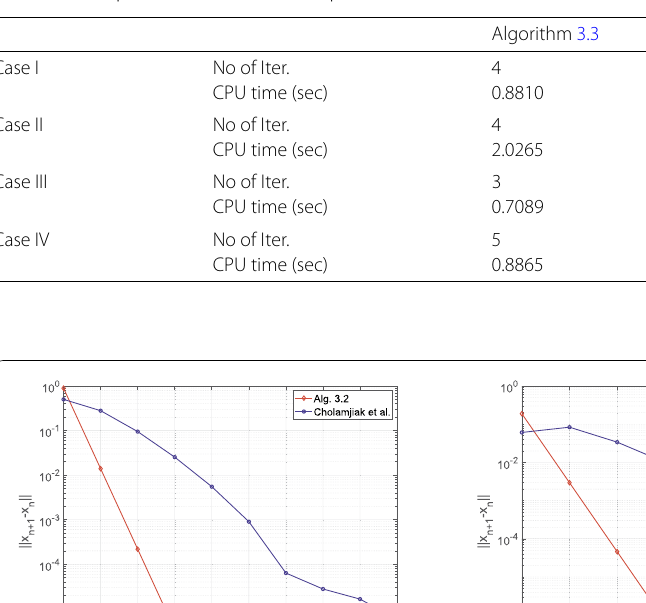
Table 2 Computation result for Example 4.2